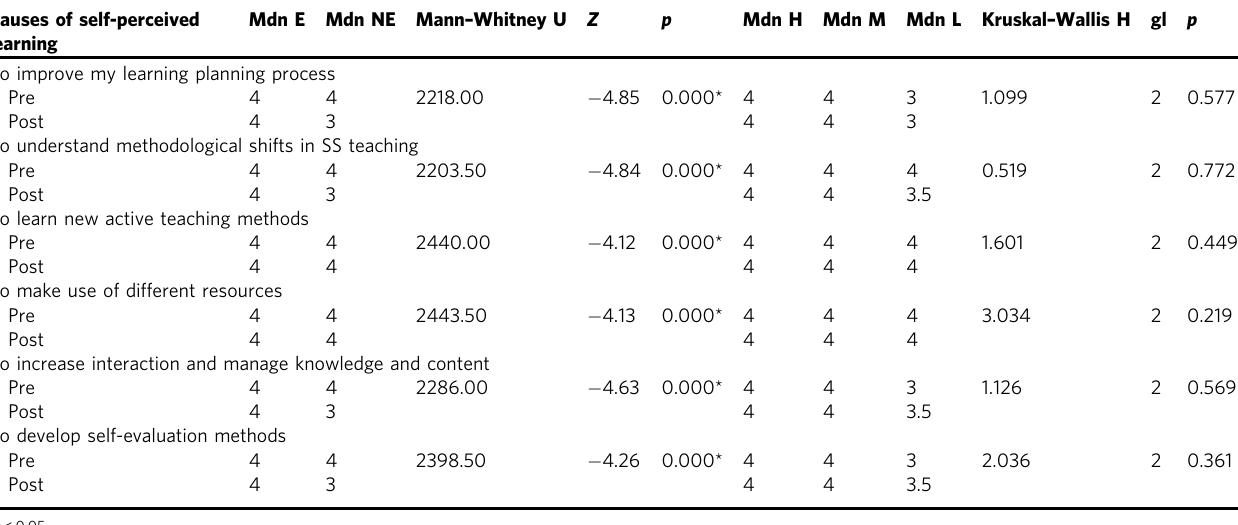
Table 6 Non-parametric results for the variables referring to self-perceived learning in this approach during the COVID-19 pandemic.